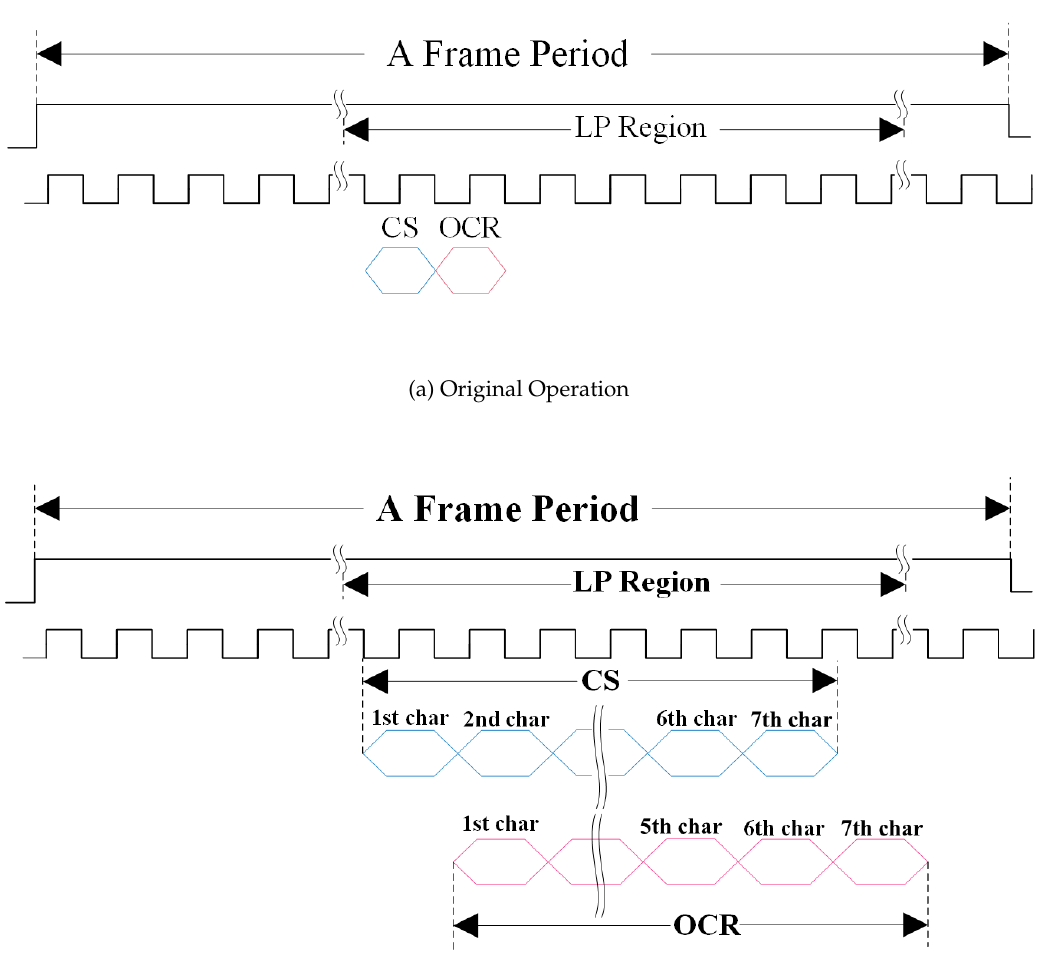
Fig. 8. Operation of CS and